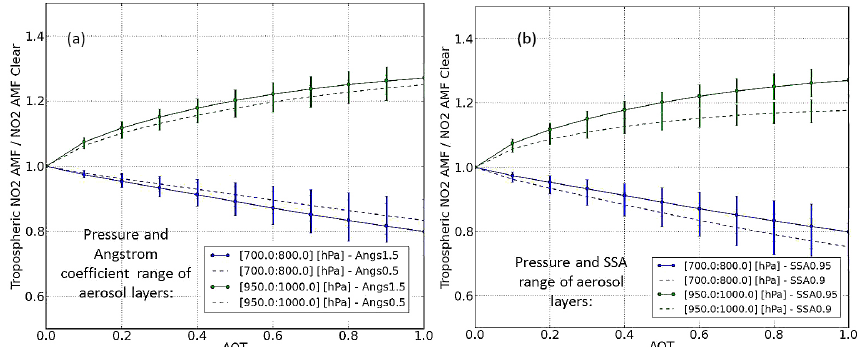
Figure 5. Similar to Fig. 3, but with only two different atmospheric aerosol layers: (a) two Ångström coefficient values: 1.5 (fine particles) and 0.5 (coarse particles); (b) two SSA values: 0.95 and